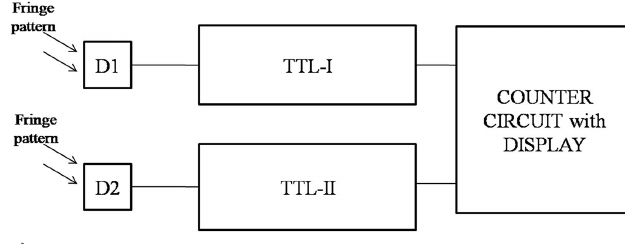
Figure 4 Block diagram of the fringe counter.